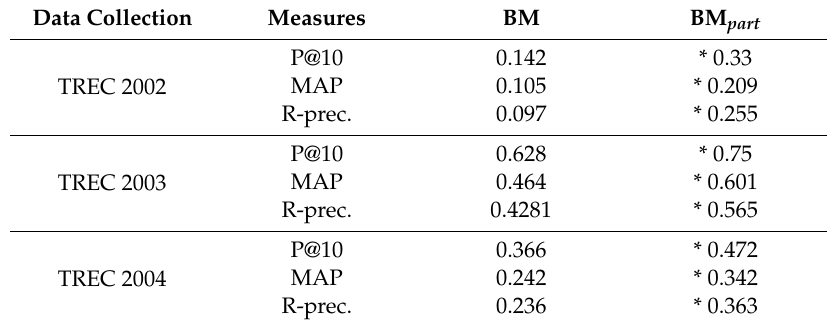
Table 4. Test results of methods BM25 and BM25 part ( k 1 = 1.5, b = 0.75, k 3 = 0). Data Collection